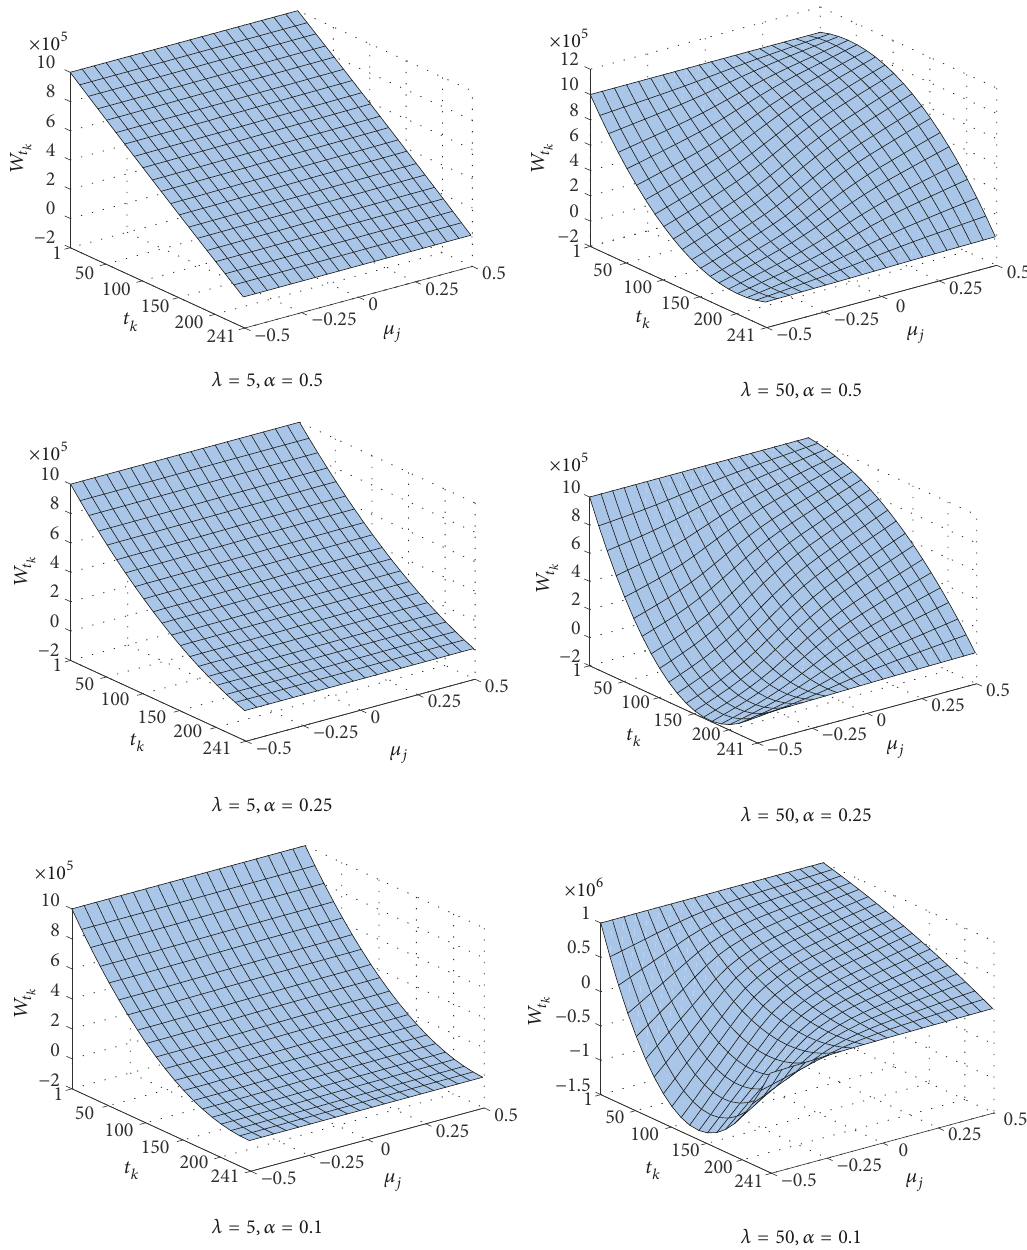
Figure 3: The influence of parameters 𝜇 𝑗 and 𝛼 on execution